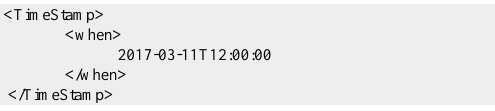
Figure 4. example of time stamp tags in KML